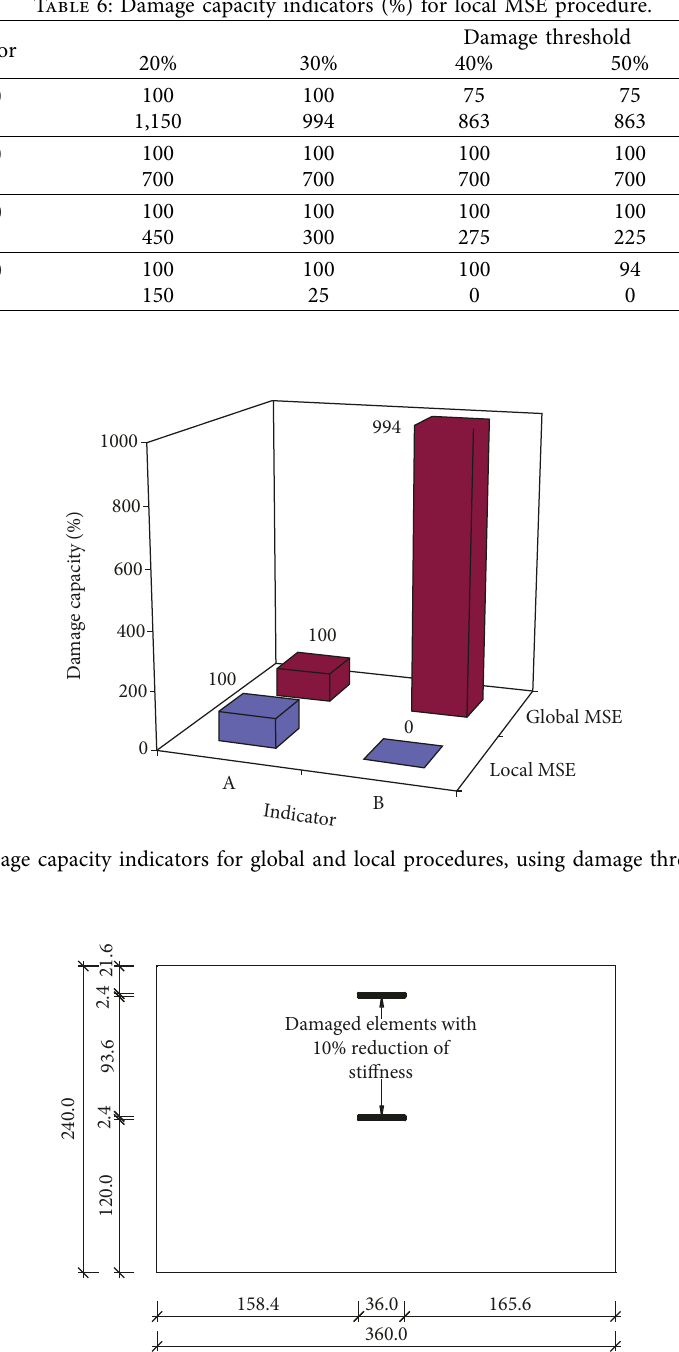
Figure 12: Rectangular plate, four fixed boundaries, with two cracks.